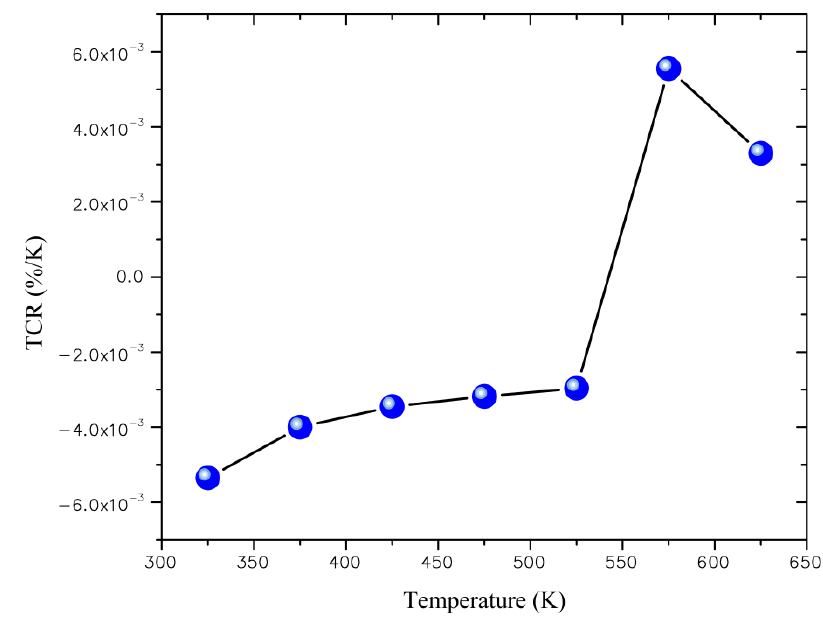
Figure 7. ZnO: F thin-film resistor temperature Figure 7. ZnO:F thin-film resistor temperature coefficient.